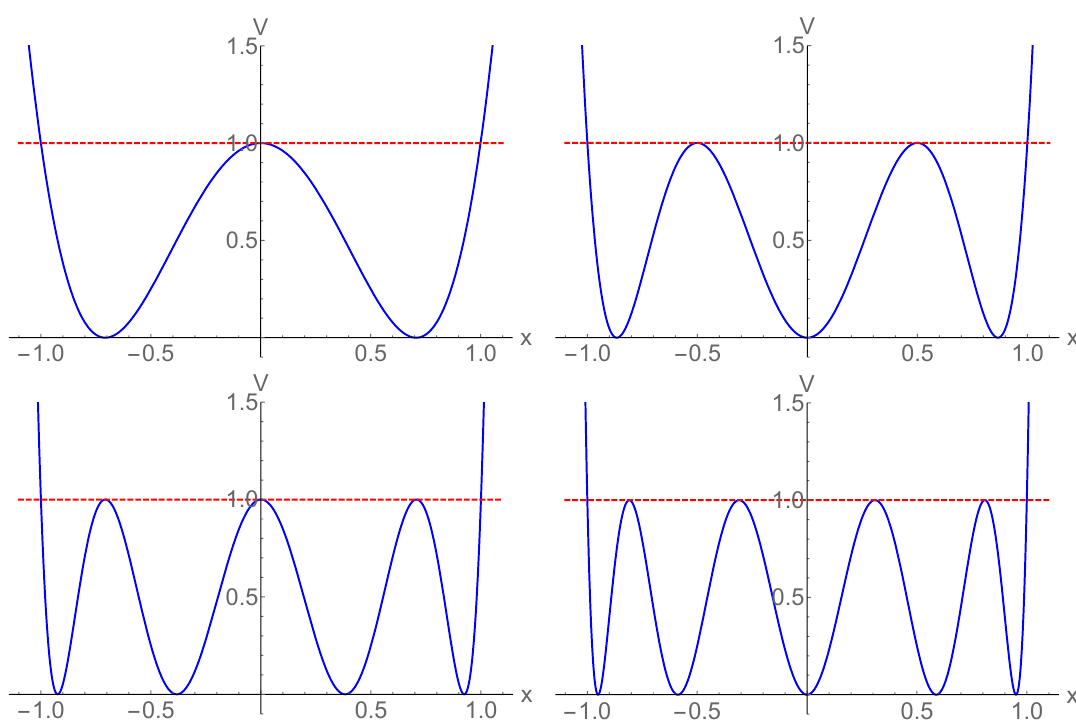
Figure 1 . The Chebyshev potentials V ( x ) = T 2 ( x ) in (3.1), for m = 2 ; 3 ; 4 ; 5. (The case m = 1 m corresponds to the soluble quadratic potential, i.e. harmonic oscillator.) Note that all maxima are at energy u = 1, and all minima are at energy u = 0. This class generalizes the symmetric double well potential V ( x ) = T 2 ( x 2